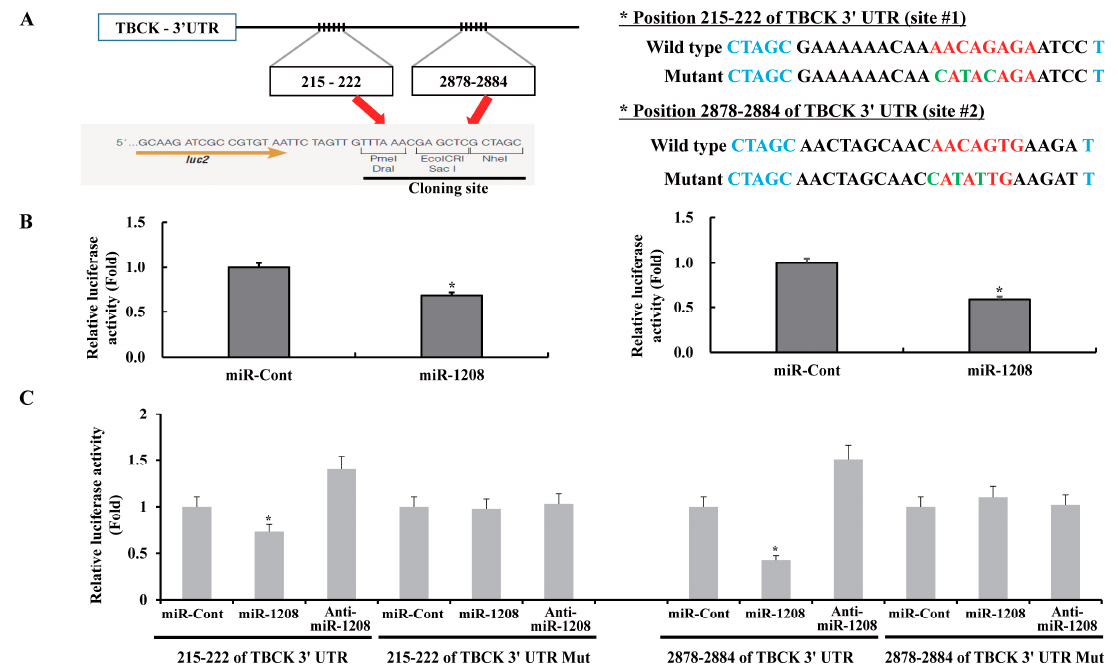
Figure 3. TBCK is a functional target of miR-1208 in renal cancer. ( A ) Schematic representation of TBCK showing putative miR-1208 target sites ( left panel ). The mutated nucleotides in the TBCK 3’-UTR mutant ( right panel ). ( B ) Luciferase activity assay with the corresponding wild-type luciferase constructs containing two different miR-1208 target sequences (site #1 or site #2) transfected with miR-Cont or miR-1208. For all luciferase activity assays, firefly luciferase values were normalized to Renilla luciferase activity and plotted as the relative luciferase activity. Data are reported as the mean ± SD ( n = 3). Student’s t -test for unpaired values was used. * indicates P < 0.05 compared to miR-Cont-transfected cells. ( C ) Luciferase assays showing the repression of wild-type UTR (TBCK 3’-UTR) or mutant UTR (TBCK 3’UTR-mutant), following the transfection of miR-1208, anti-miR-1208, and miR-Cont. Data are shown as the mean ± SD ( n = 3). * indicates P < 0.05 compared to miR-Cont-transfected cells.